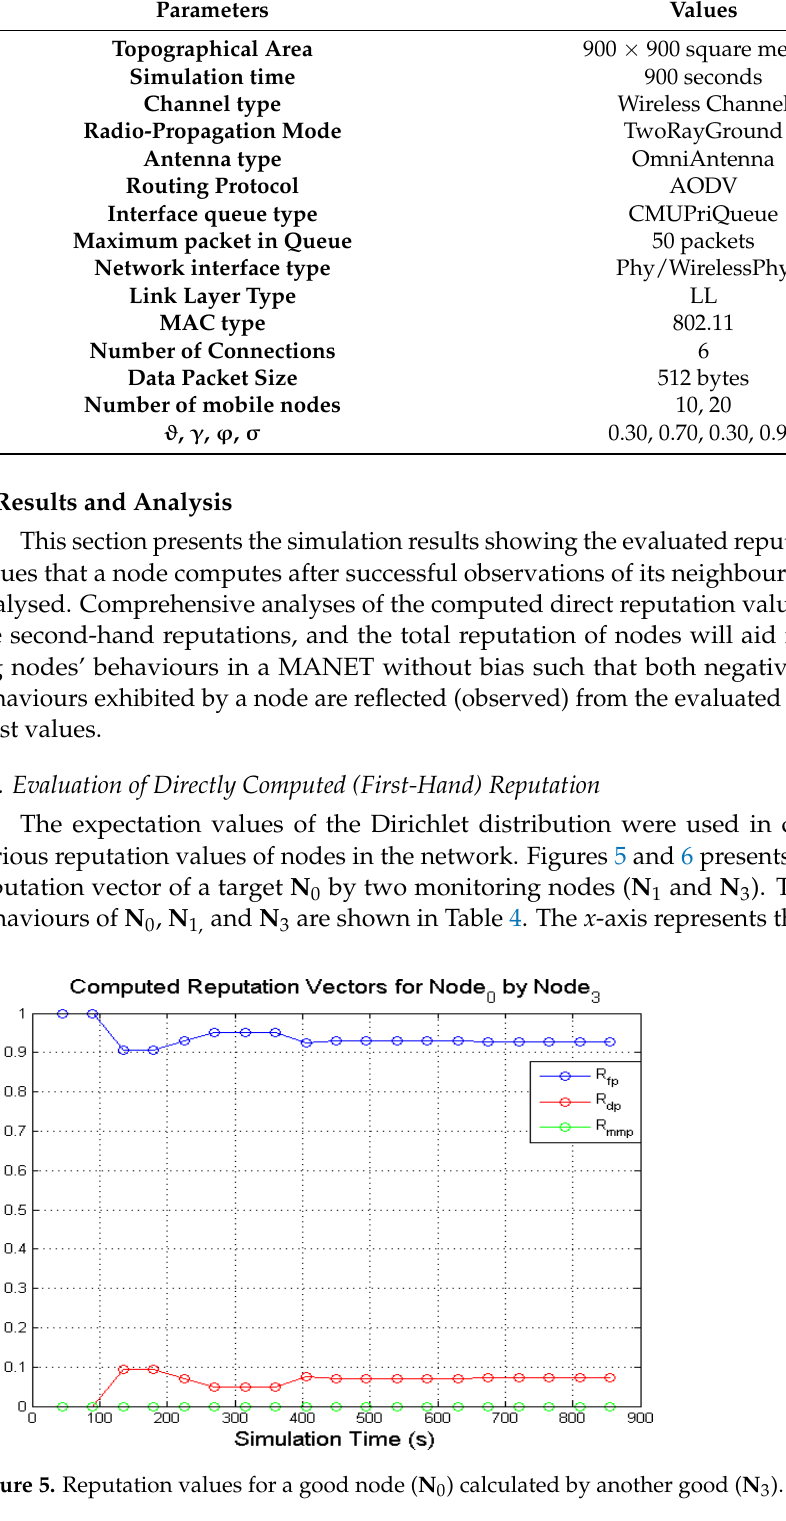
Figure 6. Reputation values for a good node ( N 0 ) calculated by periodically selfish node ( N 3 ). It is expected that a good node such as N 0 will continuously forward every data packet that is presented to it subject to a valid route being available. The direct reputation vector of a node in the proposed model, given 𝐑 (cid:2914)(cid:2919)(cid:2928)(cid:2915)(cid:2913)(cid:2930)(cid:2928)(cid:2915)(cid:2926)(cid:2931)(cid:2930)(cid:2911)(cid:2930)(cid:2919)(cid:2925)(cid:2924) = (cid:3451)𝐑 (cid:2916)(cid:2926) , 𝐑 (cid:2914)(cid:2926) , 𝐑 (cid:2923)(cid:2923)(cid:2926) (cid:3455) , is a com- bination of three components as explained in Section 4.2.2. (cid:3451)𝐑 (cid:2916)(cid:2926) , 𝐑 (cid:2914)(cid:2926) , 𝐑 (cid:2923)(cid:2923)(cid:2926) (cid:3455) represents the 3-tuples ⟨𝐑 (cid:2886)(cid:2915)(cid:2924)(cid:2915)(cid:2932)(cid:2925)(cid:2922)(cid:2915)(cid:2924)(cid:2930) , 𝐑 (cid:2903)(cid:2915)(cid:2922)(cid:2916)(cid:2919)(cid:2929)(cid:2918) , 𝐑 (cid:2897)(cid:2911)(cid:2922)(cid:2919)(cid:2913)(cid:2919)(cid:2925)(cid:2931)(cid:2929) ⟩. As illustrated in Figures 5 and 6, the target node ( N 0 ) is observed as forwarding data packets continuously by N 1 and N 3 which is reflected on the computed values of 𝐑 (cid:2916)(cid:2926) . It can also be observed that both monitoring nodes ( N 1 and N 3 ) computed respective values for 𝐑 (cid:2914)(cid:2926) from N 0 activities. Although N 0 is selected to display benevolent behaviours dur- ing the simulation. The computed 𝐑 (cid:2914)(cid:2926) was as a result of incorrect observation outcomes. Further investigations from analysing the NS2 trace files show that the few packets dropped by N 0 was as a result of buffer overflow of the packet queue. The packet queue holds packets that are meant for forwarding. It has a maximum number of packets it holds (50 packets in the simulations) while the forwarding node sources for the required path for the packets from the route cache. As more packets are received for forwarding, a good node may unintentionally drop the packets due to buffer overflow. Additionally, some of the dropped packets were as a result of packet expiration caused by queue time out or when packet TTL (Time-To-Live) reaches zero. Every packet has a limit it can stay in a queue before it times out. If the required path is not found before the queue times out, that packet may be dropped. These various packet drops may result in a good node being perceived as displaying selfish behaviour. However, since computing the direct reputa- tion values are executed after monitoring is completed in the given monitoring interval as described in Section 4.2.2. As long as 𝐑 (cid:2914)(cid:2926) does not exceed the defined threshold, the value of 𝐑 (cid:2914)(cid:2926) is negligible. On the other hand, no value for 𝐑 (cid:2923)(cid:2923)(cid:2926) was computed all through the various monitoring windows which were expected.